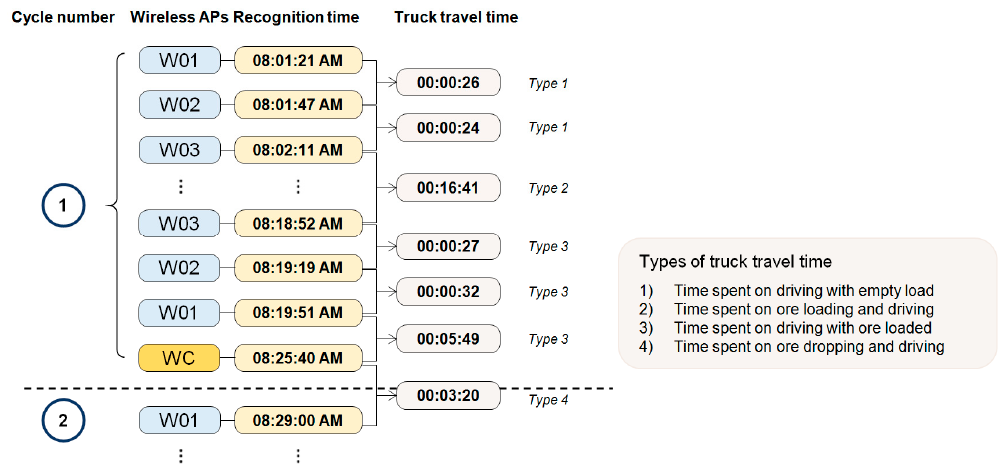
Figure 4. Diagram showing the process of classifying the truck tag recognition packet data according to the number of the haulage operation cycle, combining the data with the tag recognition packet data obtained from the crushing site, and measuring the 4 types of truck travel